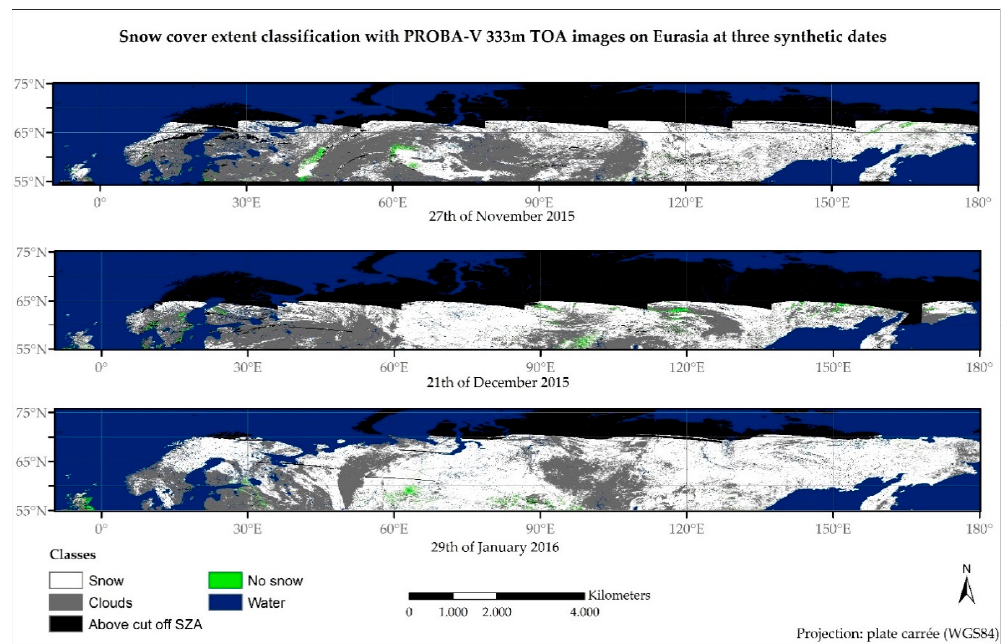
Figure 4. Snow cover extent classification with PROBA-V 333 m top-of-atmosphere images on Eurasia at three synthetic dates.